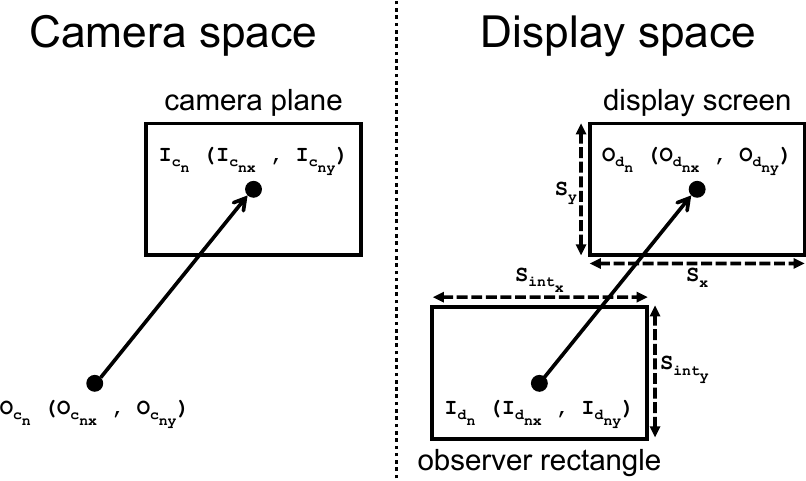
Figure 2. Camera space and display